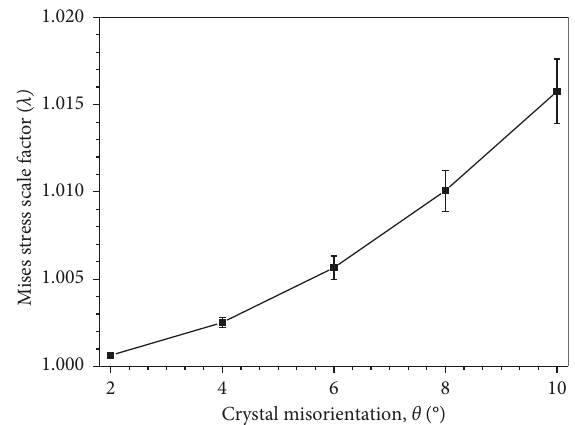
Figure 9: Mises stress scale factors along path 1 for type I